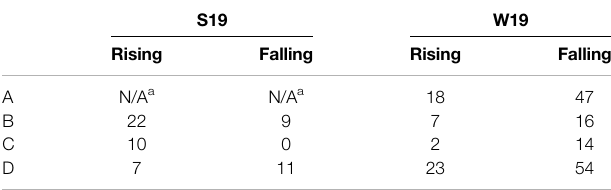
TABLE 4 | Occurrences of ampli fi cation during each 20-min calculated bulk statistic at each site during rising or falling